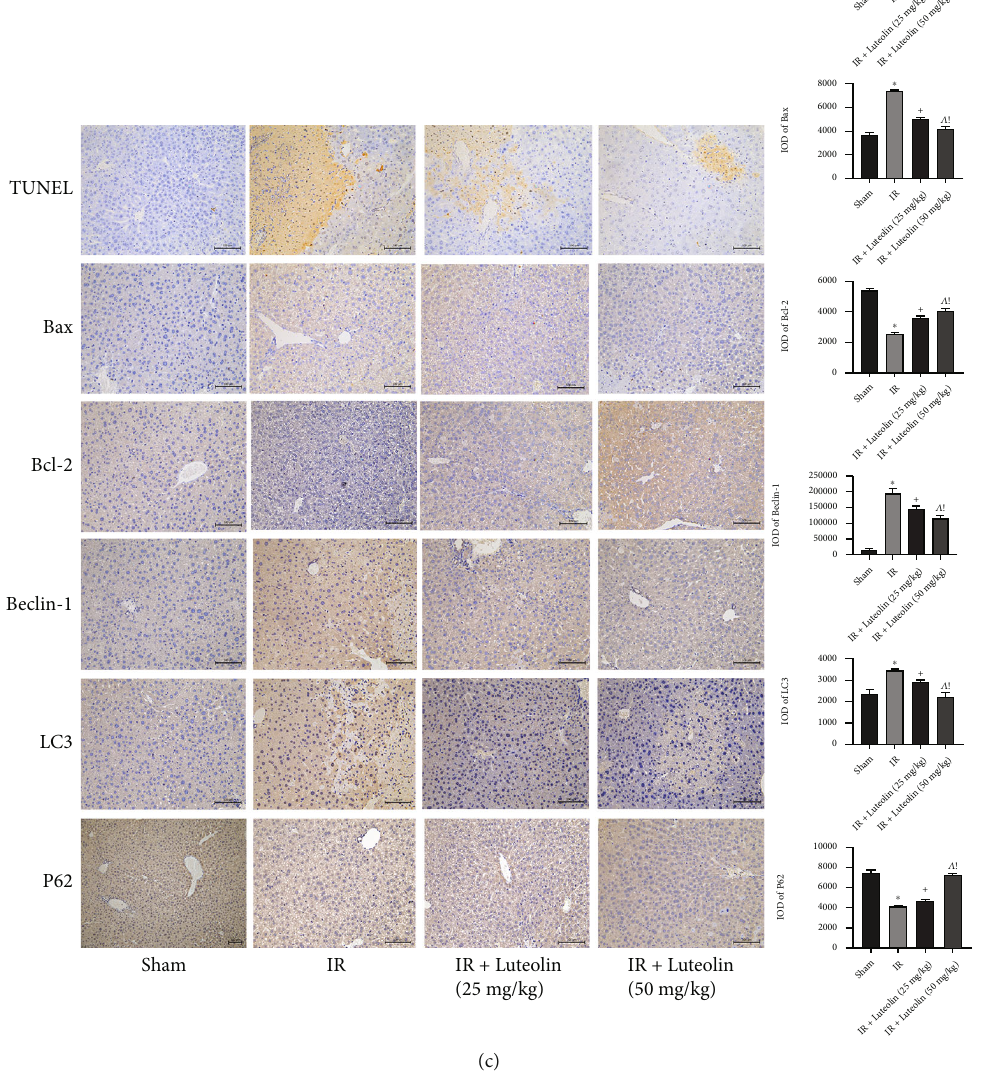
Figure 4: Luteolin attenuated IR-induced apoptosis and autophagy. (a) The relative mRNA levels of Bax, caspase 9, LC3, and p62. (b) Protein expression of apoptosis- and autophagy-related proteins. (c) After 6 h reperfusion, liver tissues were stained by TUNEL and observed under light microscopy (original magni fi cation, × 200). Immunohistochemistry was used to detect Bcl-2, Bax, Beclin-1, LC3, and P62 expressions in liver tissues (original magni fi cation, × 200). The IOD sum of brown area to total area was analyzed with the Image-Pro Plus software 6.0. Data were presented as mean ± SD ( n = 6 ; ∗ p < 0 : 05 for IR vs. sham; + p < 0 : 05 for IR+luteolin (25 mg/kg) vs. IR; ^ p < 0 : 05 for IR+luteolin (50 mg/kg) vs. IR; ! p < 0 : 05 for IR+luteolin (50 mg/kg) vs. IR+luteolin (25